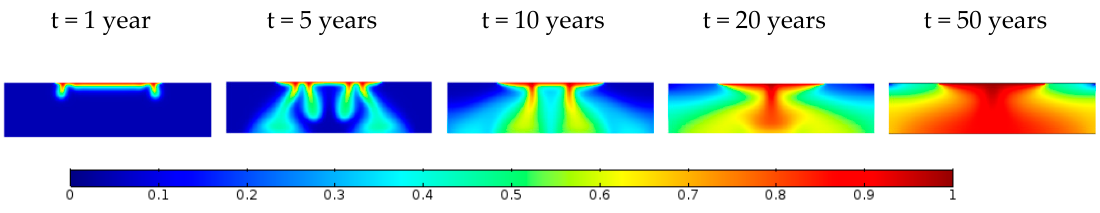
Figure 3. Concentration distribution of the homogeneous Elder problem.